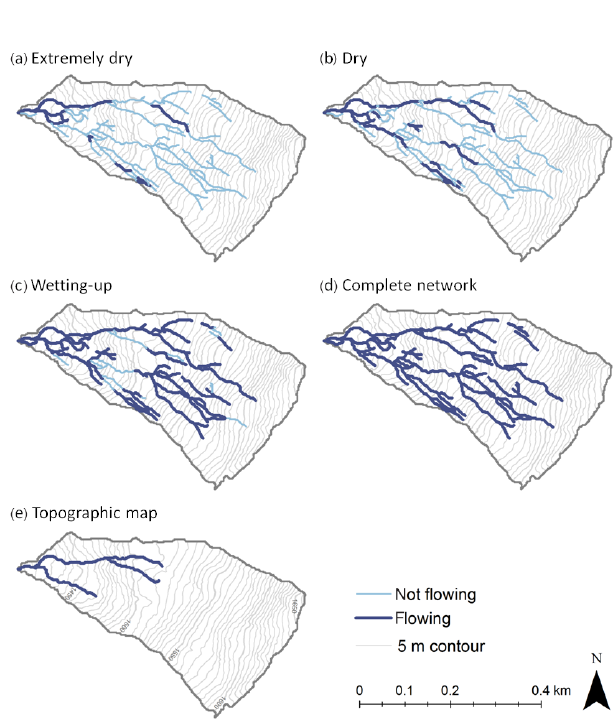
Figure 2. Maps of the five stream networks (flowing in dark blue and not flowing in light blue) used in this study. (a) Extremely dry conditions observed on 21 August 2018; (b) dry conditions ob- served on 2 November 2016; (c) wetting-up conditions observed during a rainfall event on 25 October 2016; (d) the complete stream network assumed to represent the flowing stream network during extremely wet conditions; (e) the stream network shown on the 1:25000 topographic map (see Fig. 1). The length of the flowing stream network changes dramatically with wetness conditions and is significantly underrepresented by the stream network shown on the topographic